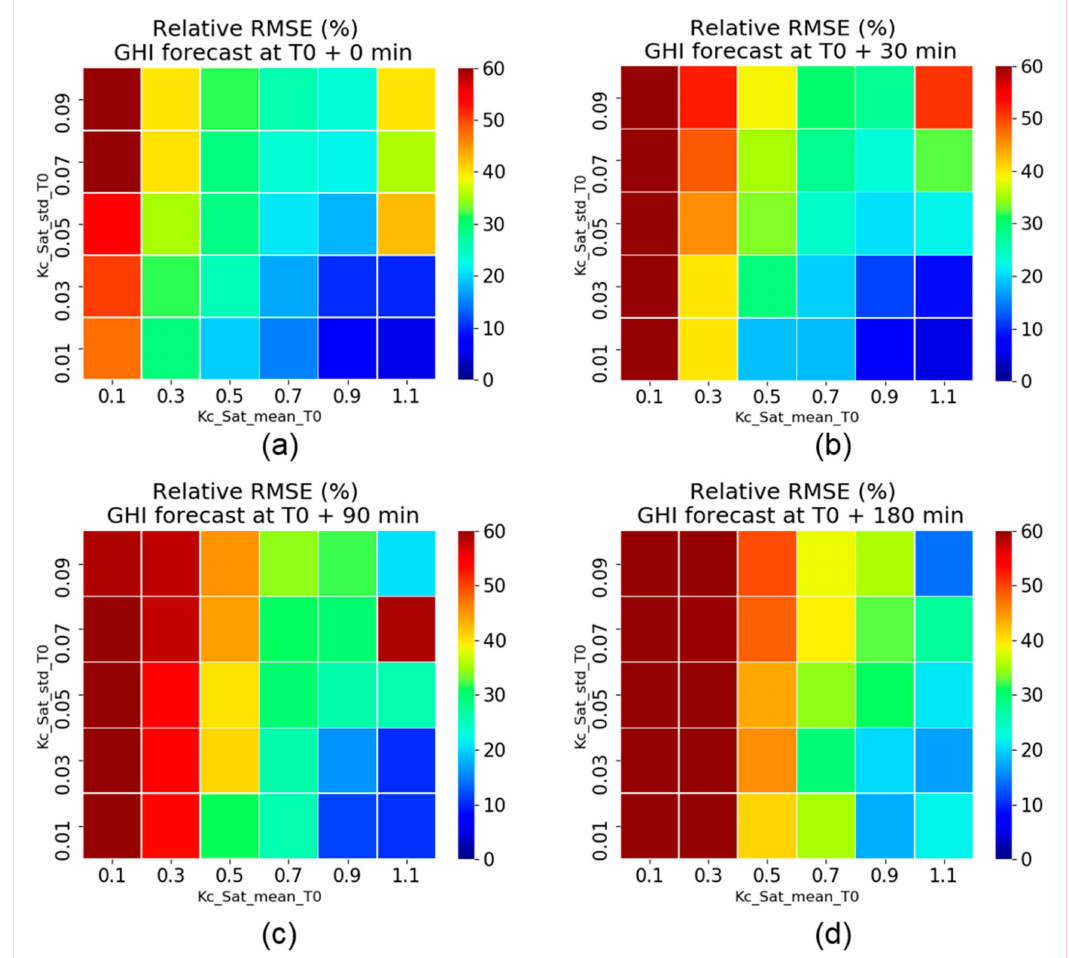
Figure 8. Heatmaps representing the relative RMSE (%) expressed as a function of the mean and the standard deviation of K c in a 7 × 7 MSG-HRV pixels area centered on Palaiseau from 1 July 2017 to 30 June 2020 with SZA inferior to 78 ◦ . Each heatmap represents a specific time horizon. ( a ) T0 + 0 min; ( b ) T0 + 30 min;( c ) T0 + 90 min; ( d ) T0 + 180